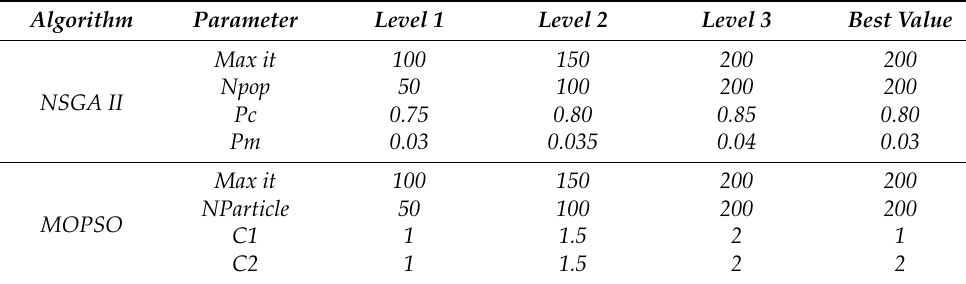
Table 10. Proposed parameter levels for tuning of NSGA II and MOPSO.